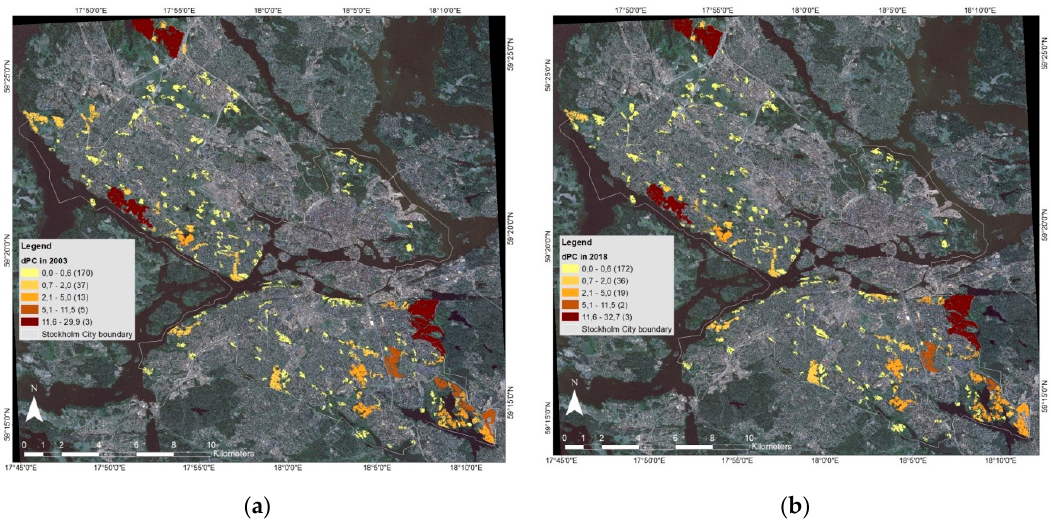
Figure 8. dPC values per crested tit habitat patch in ( a ) 2003 and in ( b ) 2018. The number of patches in each value interval is noted in parentheses.